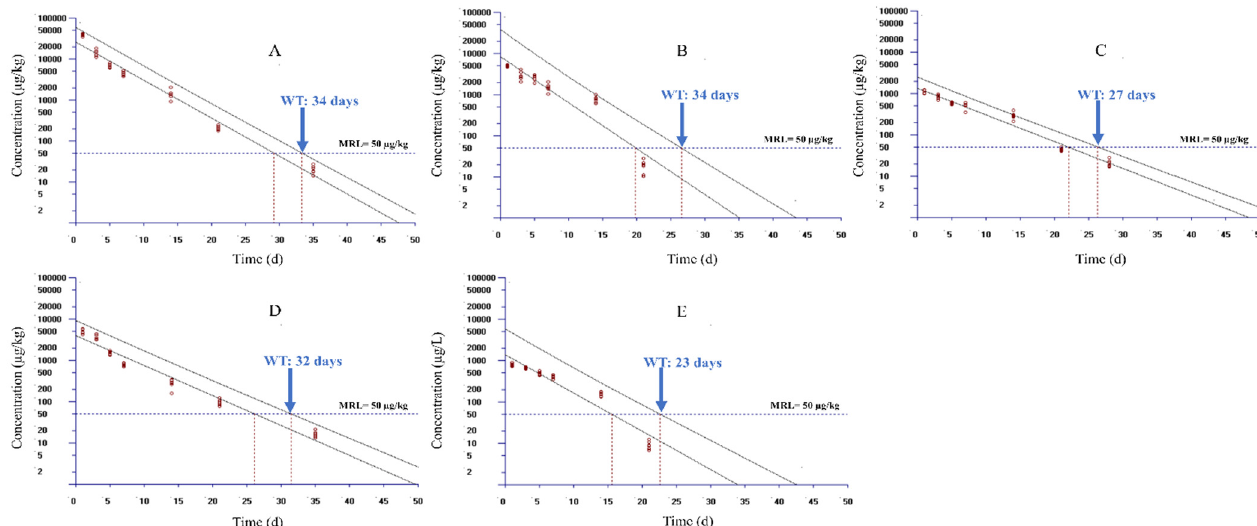
Figure 3. Calculated withdrawal times of doxycycline in yellow catfish ( Pelteobagrus fulvidraco ) following continuous 3-day oral gavage at 20 mg/kg/day based on the MRL standard in Japan using the WT 1.4 software. Panels ( A – E ) show the results for liver, kidney, muscle + skin, gill, and plasma, respectively. MRL, maximum residue limit for doxycycline from the Ministry of Agriculture, Forestry and Fisheries of Japan.